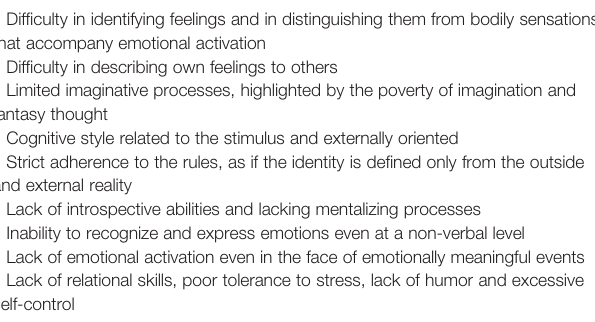
TABLE 1 | The construct of alexithymia: main features. (cid:129) Dif fi culty in identifying feelings and in distinguishing them from bodily sensations that accompany emotional activation (cid:129) Dif fi culty in describing own feelings to others (cid:129) Limited imaginative processes, highlighted by the poverty of imagination and fantasy thought (cid:129) Cognitive style related to the stimulus and externally oriented (cid:129) Strict adherence to the rules, as if the identity is de fi ned only from the outside and external reality (cid:129) Lack of introspective abilities and lacking mentalizing processes (cid:129) Inability to recognize and express emotions even at a non-verbal level (cid:129) Lack of emotional activation even in the face of emotionally meaningful events (cid:129) Lack of relational skills, poor tolerance to stress, lack of humor and